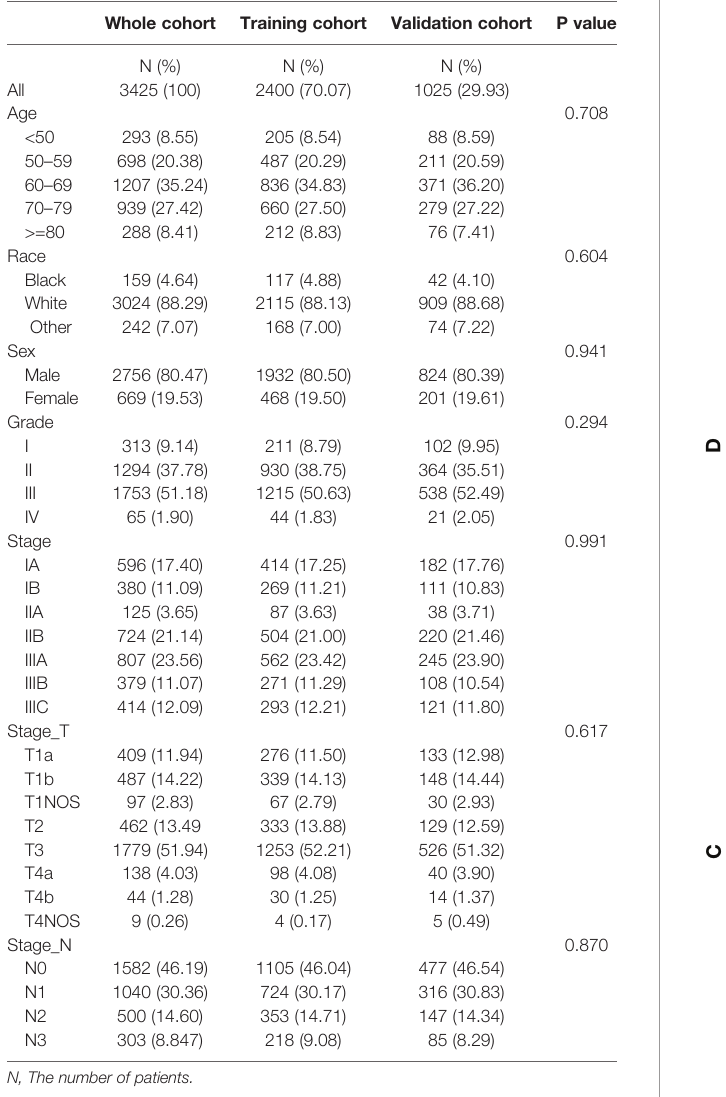
cohort ( Figure 2 and Table 1 ). The veri fi cation cohort AUC of 3- and 5-year OS were 0.707 and 0.715, respectively ( Figure 6B ). The calibration curve of 3- and 5-year OS showed the best consistency between Nomogram predictions consistent with the training cohort ( Figure 7B ).